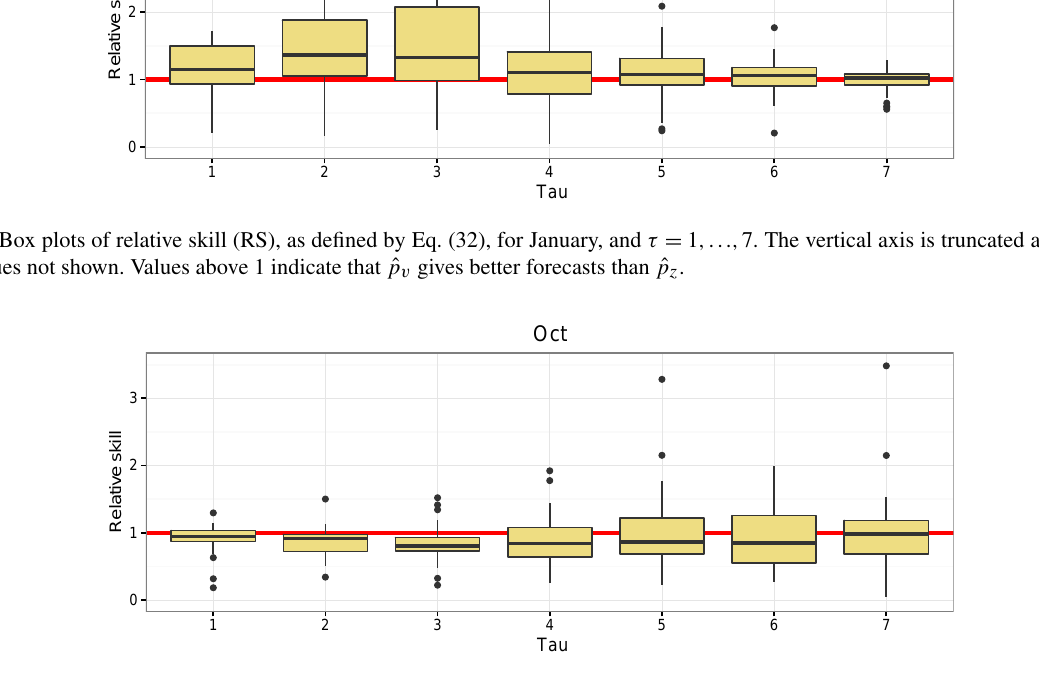
where z ( t + τ ) was extracted from the complete Niño